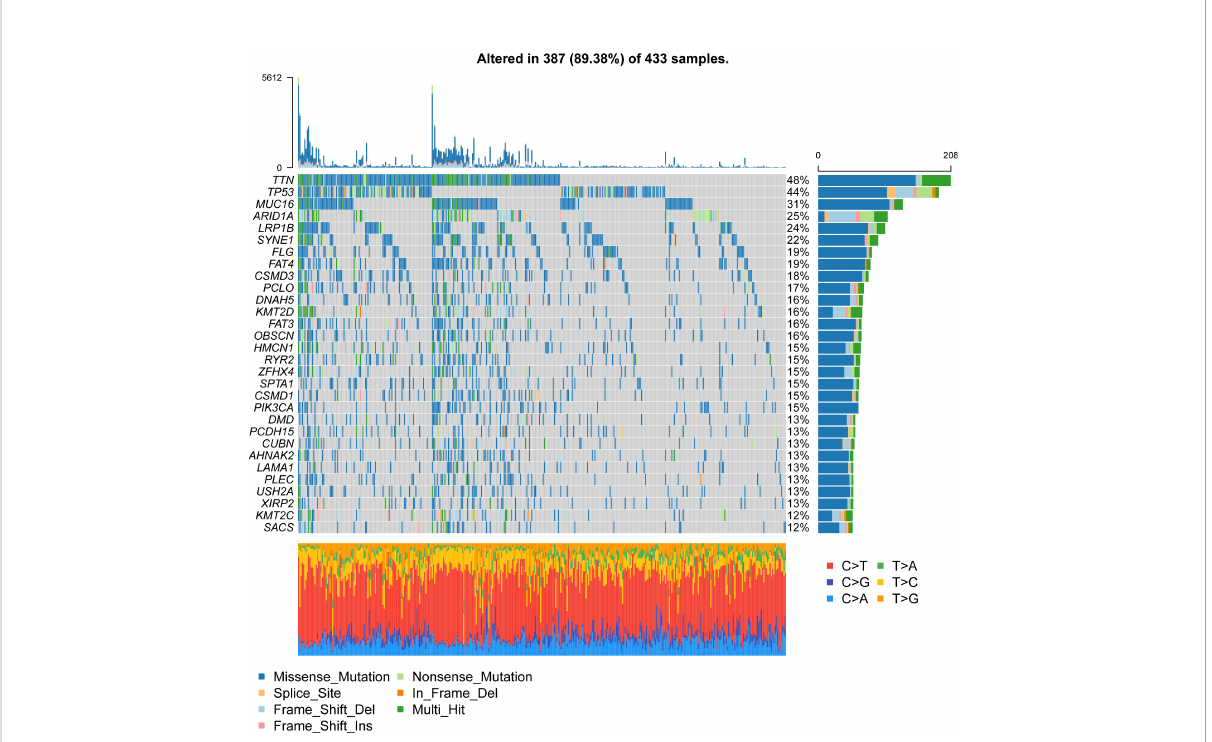
FIGURE 2 Waterfall plot of gene mutations in the TCGA_STAD dataset.